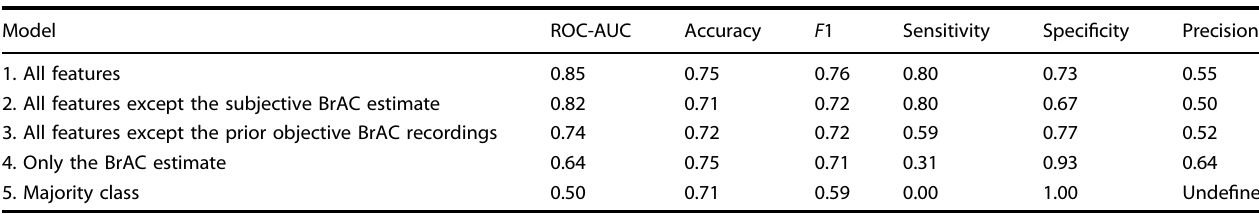
Table 1. Model performance characteristics and